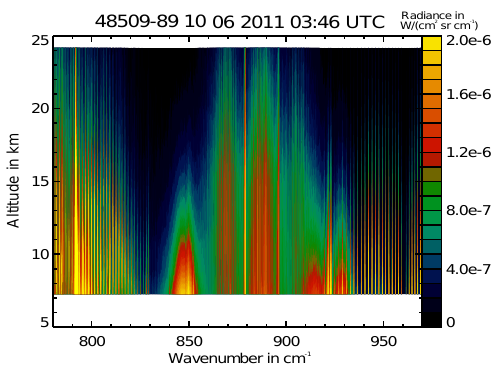
Figure 1. MIPAS radiances measured in profile 89 of orbit 48509 (around 48 ◦ S). This clear air case shows low radiances in the broad window region around 830cm − 1 and multiple narrow windows be- tween 950 and 970cm − 1